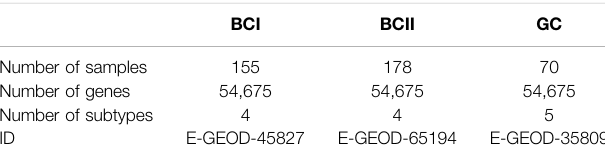
TABLE 1 | Details of the three data